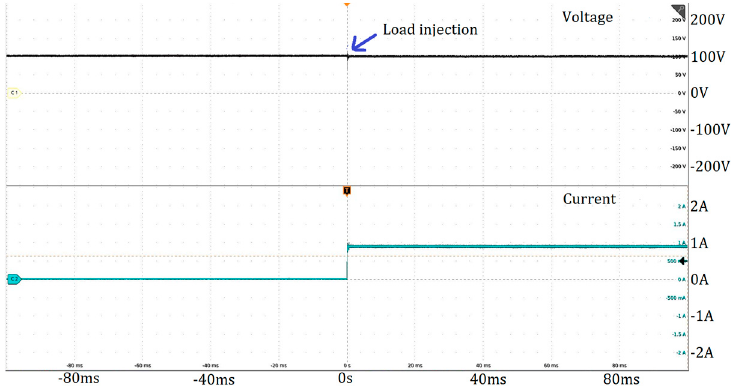
Figure 9. Responses of the stand-alone inverter for DC reference voltage.